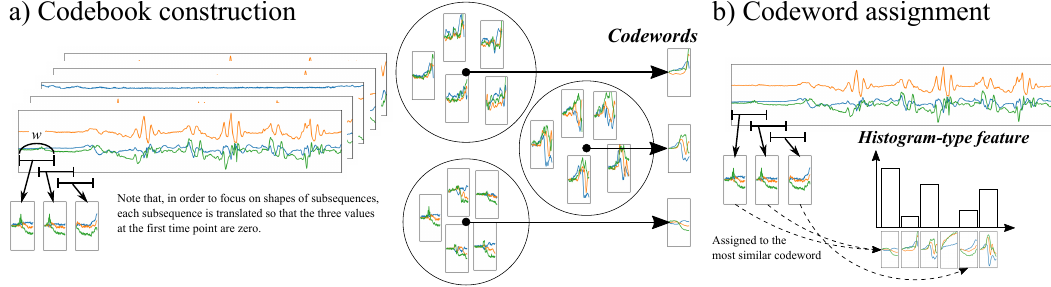
Figure 2. An overview of our codebook-based feature extraction phase: ( a ) illustrates the codebook construction step where subsequences collected from a large number of sequences are grouped into clusters, and the center of each cluster is regarded as a codeword; ( b ) depicts the codeword assignment step where each of subsequences in a sequence is assigned to the most similar codeword. As a result, the sequence is represented as a histogram-type feature indicating the frequency of each